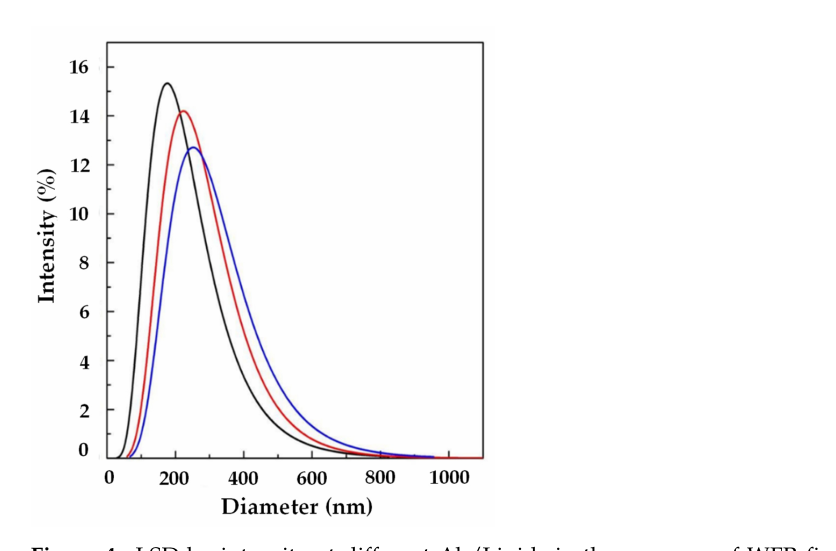
Figure 2. LSD by intensity at different Ab/Lipids in the presence of WFR fixed at 1 mL/min: ( ) 0, ( ) 0.625, ( ) 1.25, and ( ) 2.50% ( w / w ). LSD: liposome size distribution Ab/Lipids: antibody ‐ to ‐ lipid mass ratio, WFR: water flow rate.